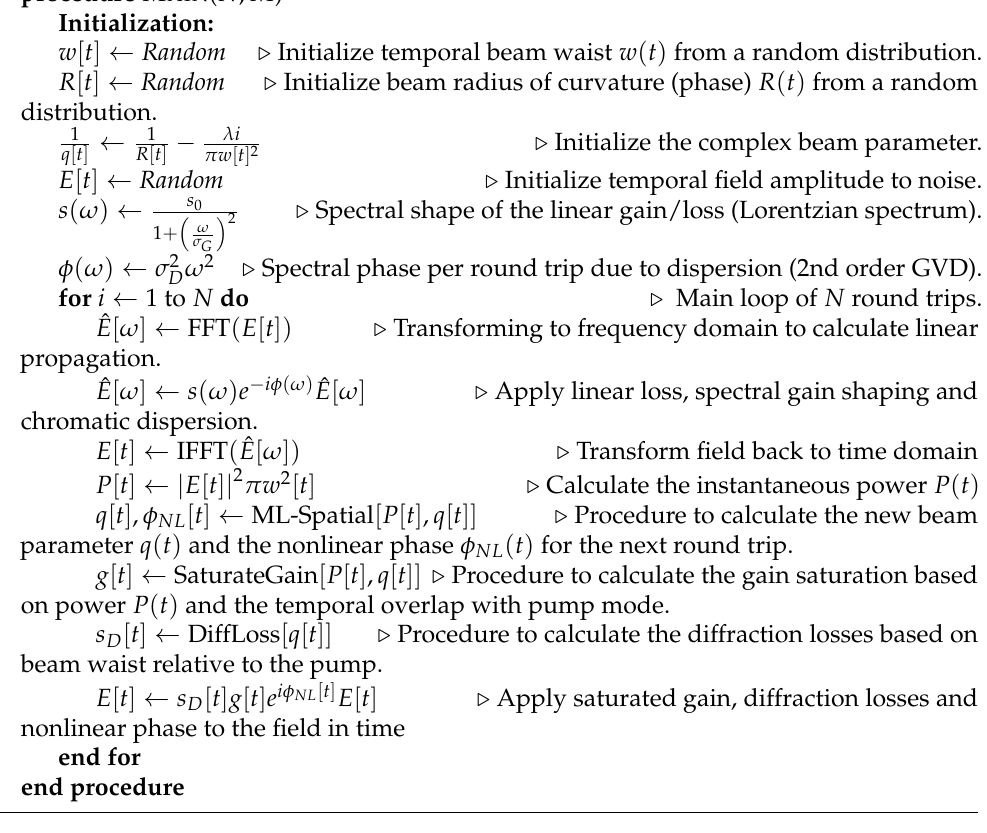
Algorithm A1 Main loop with temporal